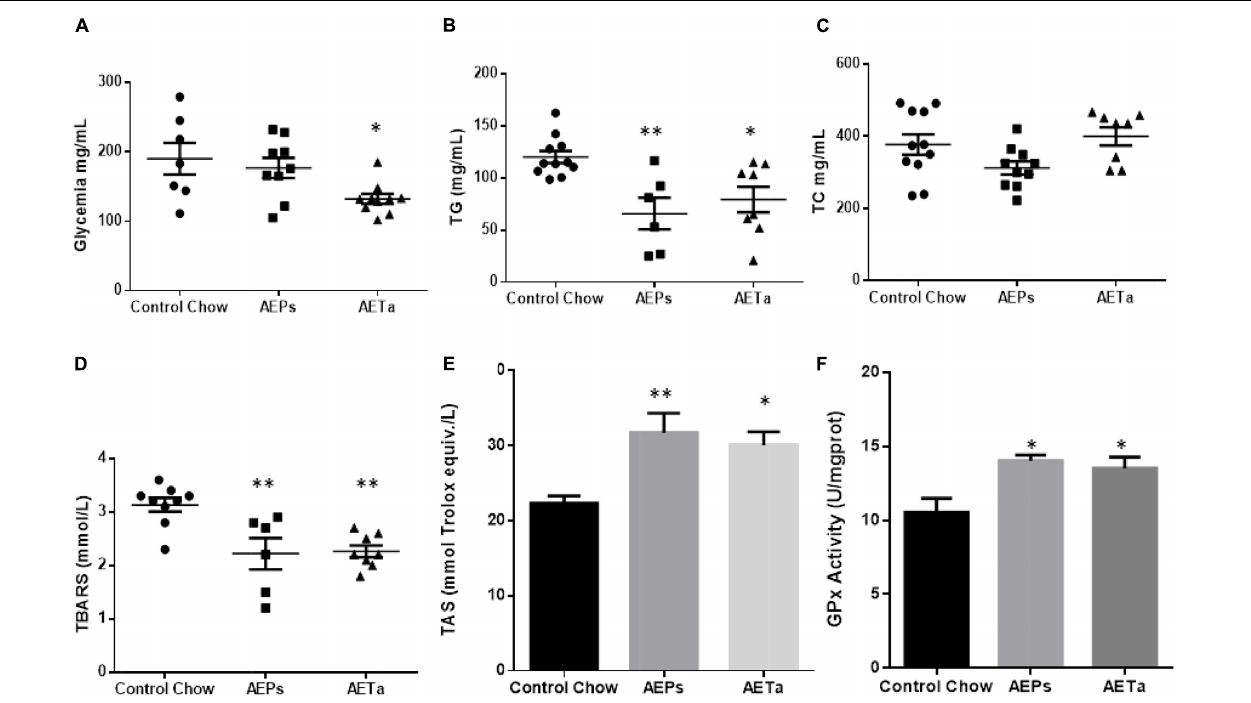
FIGURE 5 | Effect of Prosopis strombulifera or Tessaria absinthioides on (A) fasting glycemia, (B) triglyceridemia, (C) total cholesterolemia, (D) plasma TBARS, (E) total antioxidant status (TAS) in plasma, and (F) liver GPx activity. ApoE-KO mice were fed with control chow, or AEPs or AETa in the drinking water (150 or 300 mg/kg/day, respectively) during 8 weeks. Data are means ± SEM ( n = 6–9 mice per group); ∗ p ≤ 0.05; ∗∗ p ≤ 0.01 vs. control chow. TBARS, thiobarbituric acid reactive substances; ApoE-KO, apolipoprotein E-knockout; AEPs, aqueous extract of P. strombulifera ; AETa, aqueous extract of T. absinthioides